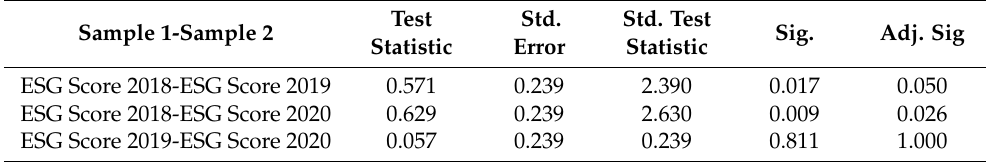
Table 7. Pairwise comparison of CSR level across years.